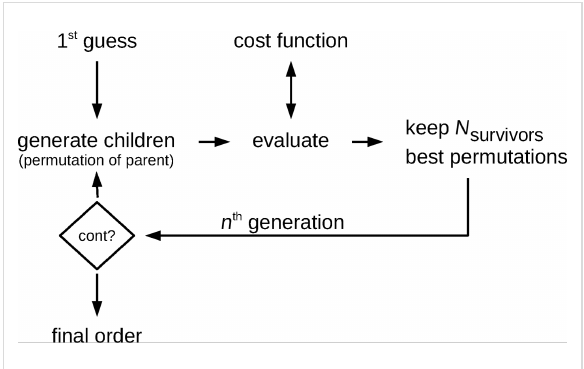
Figure 5: Schematic overview of the best permutation proximity avoiding algorithm (bpPAA). The algorithm generates new genera- tions of possible orders of the DEs of one frame by building permuta- tions of already known possible orders. Each order is evaluated by a cost function and the best order found will be employed for the current frame. As first guess the result of the angle-sorted PAA can be used. The actual cost function is chosen as the sum of Gaussians with the distance of two subsequent DEs as argument for each DE.